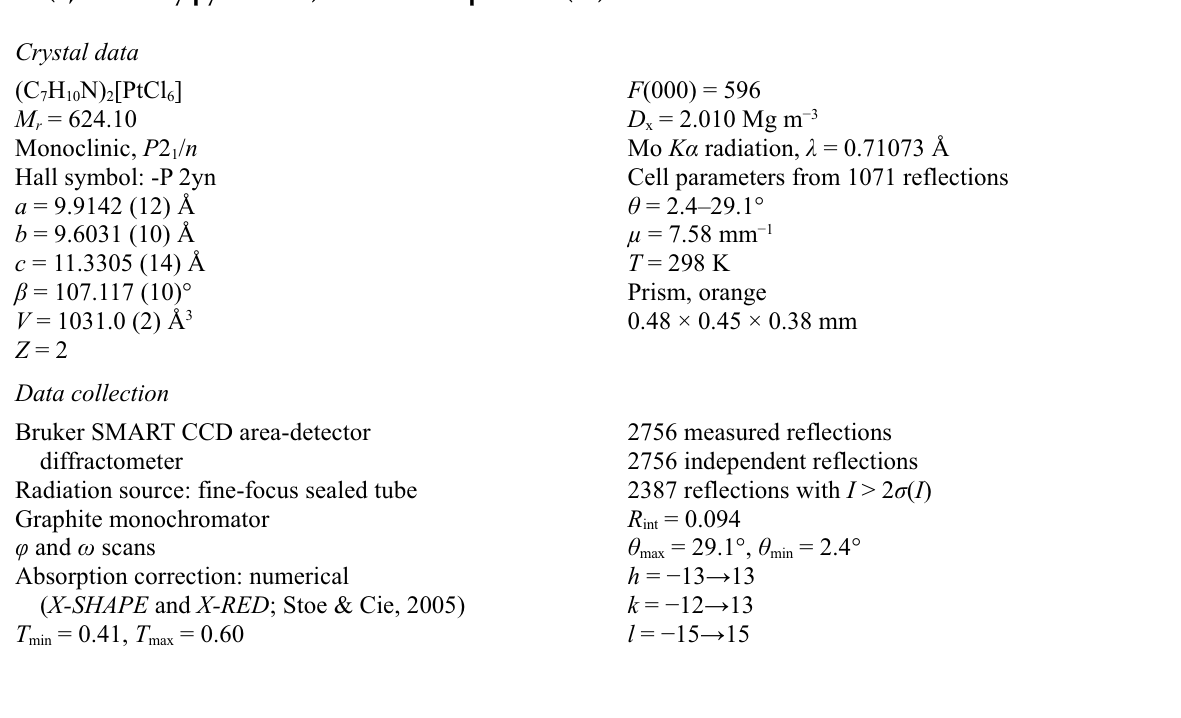
Figure 2 A packing diagram of (I). Hydrogen bonds are shown as dashed lines. Bis(2,6-dimethylpyridinium)